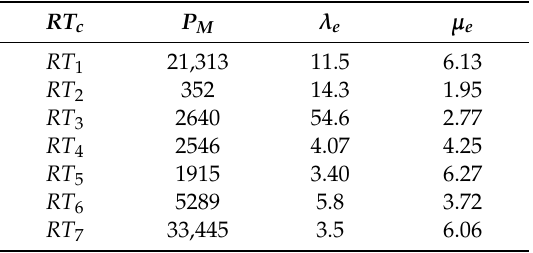
Table 10. The expert estimate of the parameter µ e by risk